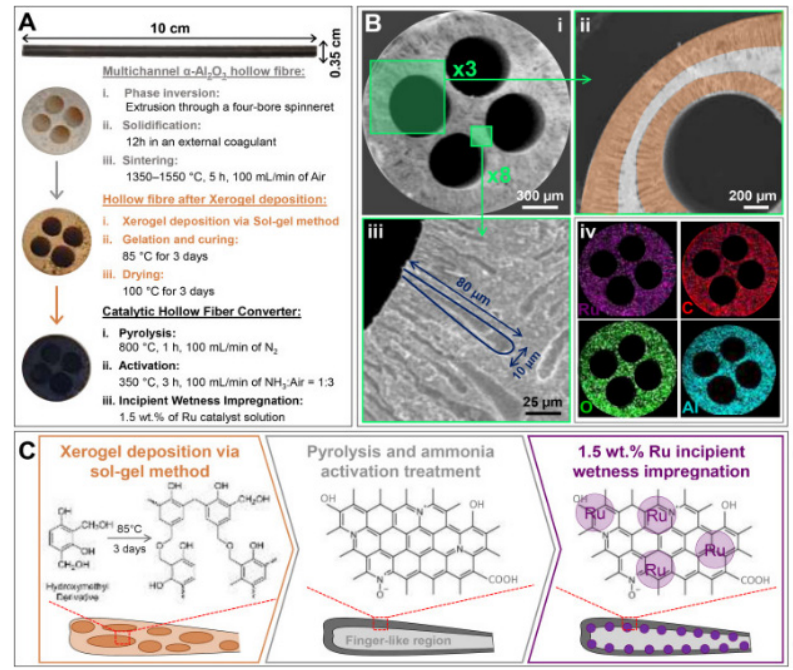
Figure 21. Ammonia decomposition with the tubular fixed-bed reactor and Cs/Ru catalyst. Reprinted with permission [38,103].